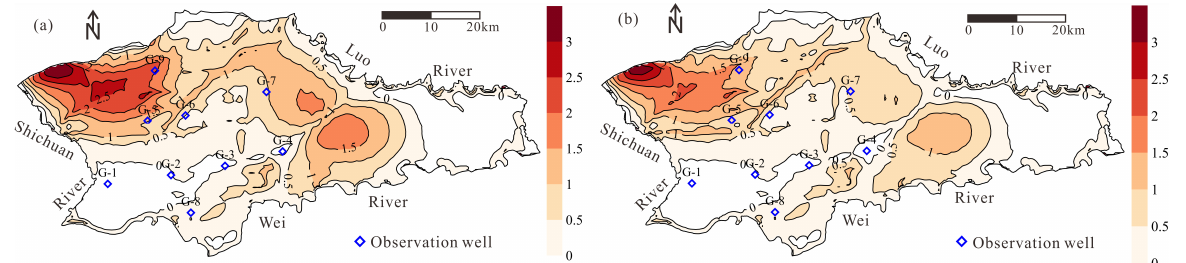
Figure 10. The decrease in groundwater level after ( a ) 20 years and ( b ) 30 years of water level